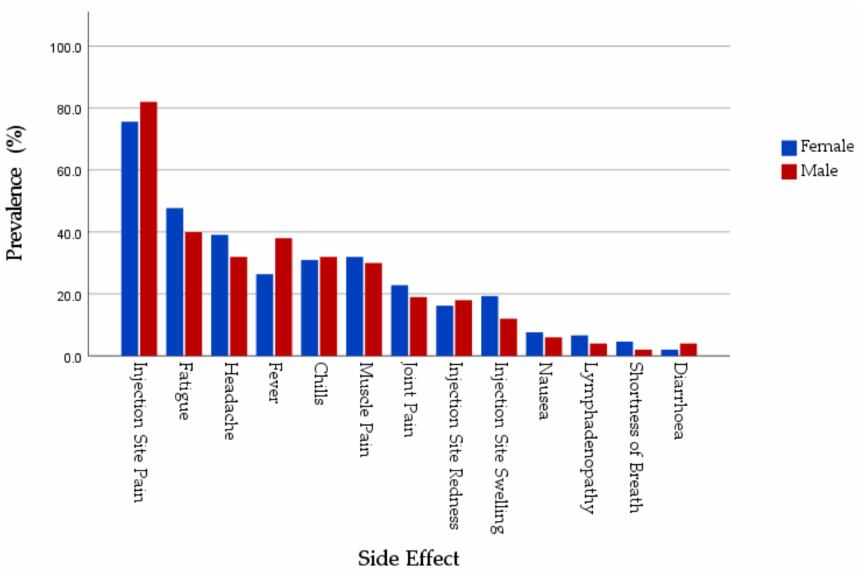
Figure 2. Gender-specific distribution of COVID-19 vaccines adverse events. In the group injected with mRNA-based vaccine group, females had higher prevalence of swelling at injection site (20.3% vs. 5.1%, statistically significant with p = 0.026), redness at injection site (18.2% vs. 15.4%), fatigue (40.5% vs. 35.9%), headache (32.4% vs. 25.6%), and muscle pain (26.4% vs. 23.1%). Overall, males, mRNA recipients had slightly higher prevalence of local side effects (84.6% vs. 80.4%, p = 0.549) and systemic SRAEs (61.5% vs. 54.1%, p = 0.403).